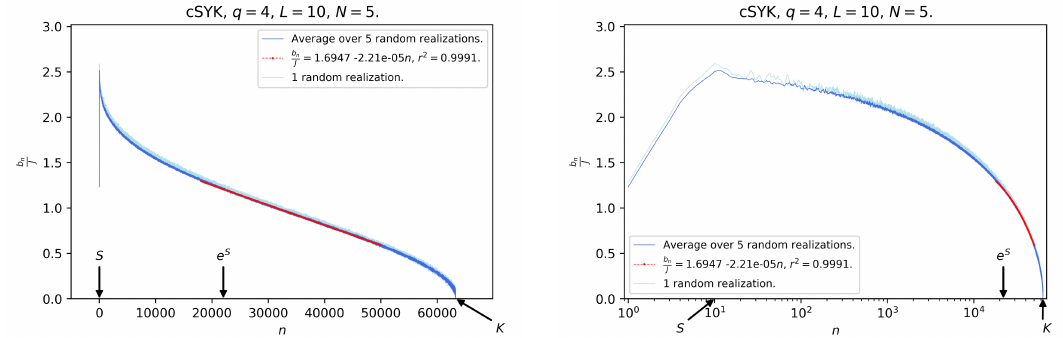
Figure 1 . Lanczos-sequence for L = 10 . Left: “The Descent” depicted with linear scale along the horizontal axis. After initial growth up to n ∼ S , a slow decrease to zero with roughly constant negative non-perturbative slope of order ∼ − 1 ∼ − e − 2 S . Fitted slope (in red) of the decaying part K is − 2 . 21 · 10 − 5 ≈ − 1 . 58 · 10 − 5 = − K − 1 . On a 1:1 scale, the horizontal axis should be at least 843 meters long. Right: logarithmic scale along the horizontal axis makes visible the initial ascent.